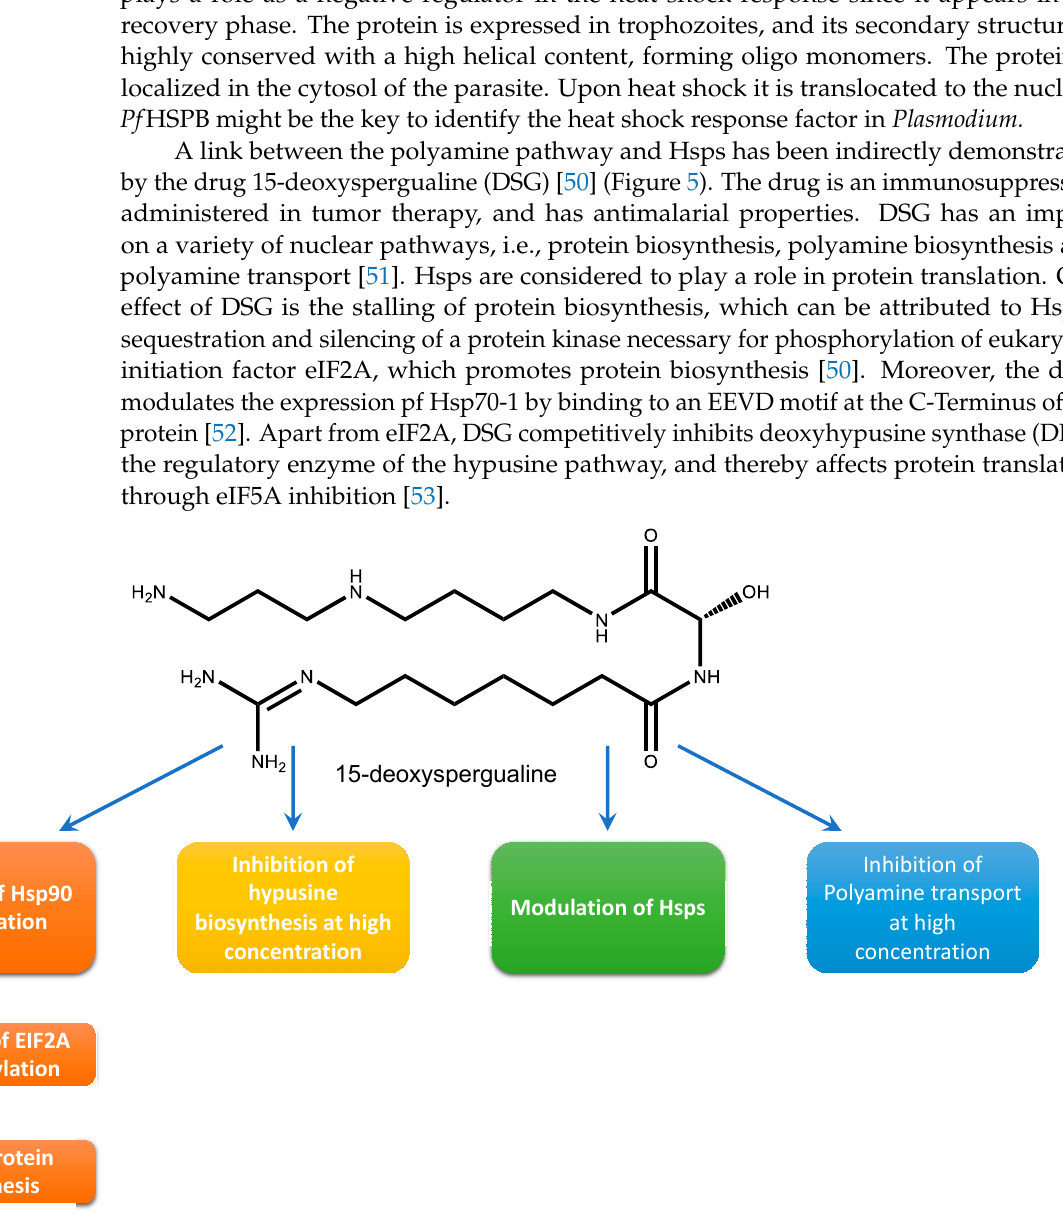
Figure 5. 15-deoxyspergualine and its mode of molecular